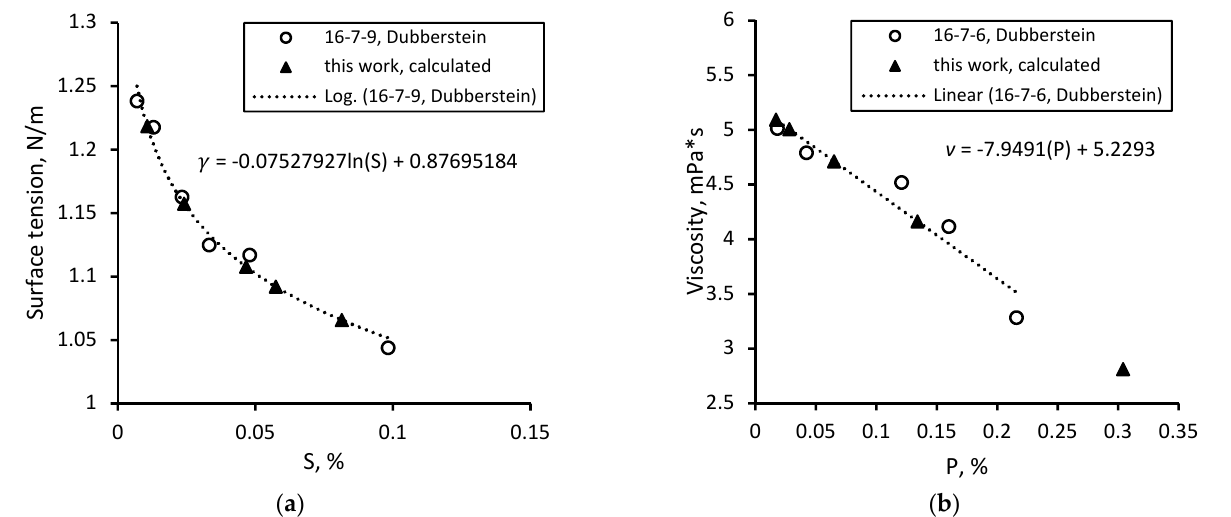
Figure 1. Effect of sulfur content on the surface tension γ of liquid 16-7-9 steel at 1600 ◦ C and calculated values for the samples in present work ( a ), modified after [11]; and effect of phosphorus content in the steel 16-7-6 on the viscosity v of the melt at 1600 ◦ C and calculated values for the samples atomized in present work, modified after [12] ( b ).